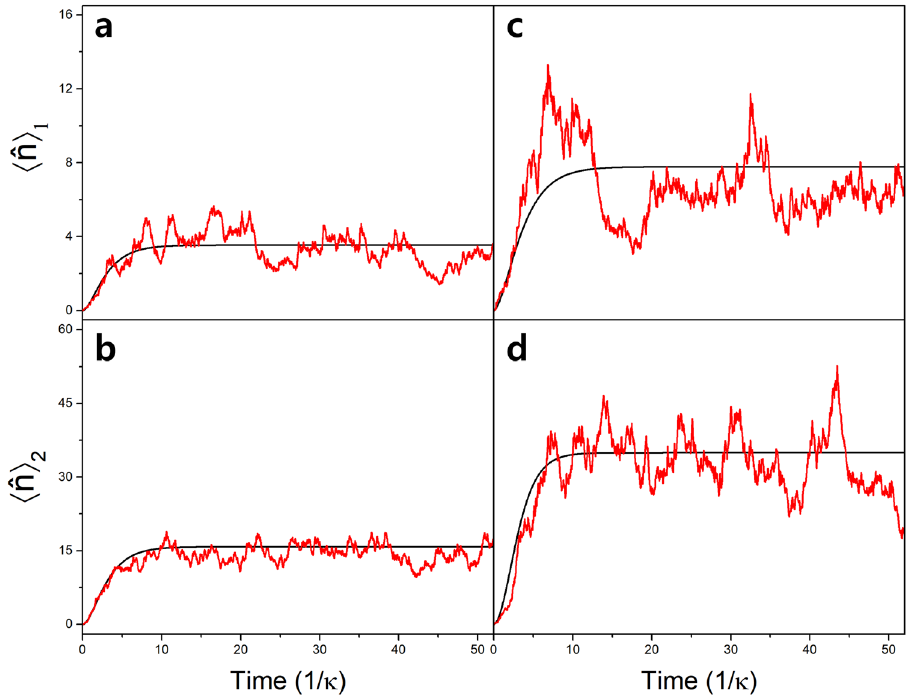
Figure 5. Time evolution of the average photon number inside the cavity. ( a,b ) One atom case (a) and two 2 , �/κ 2 and �/κ 10 . ( c,d ) One atom case (c) and two atoms case (d) with atoms case (b) with g /κ = = = 3 , �/κ 0 and �/κ 15 . Black curves indicate the regular injection cases, and the red curves indicate g /κ = = = 0.052 /κ , the cavity decay rate 1 /κ the random injection cases. We assume the interaction time τ = 1.93 µ π/ 2 . The unit time for the time scale is 1 /κ and φ = =